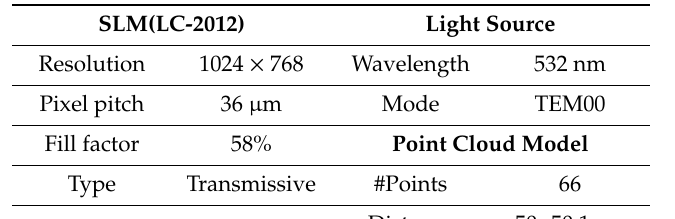
Table 2. High order’s relative intensity according to the C value.